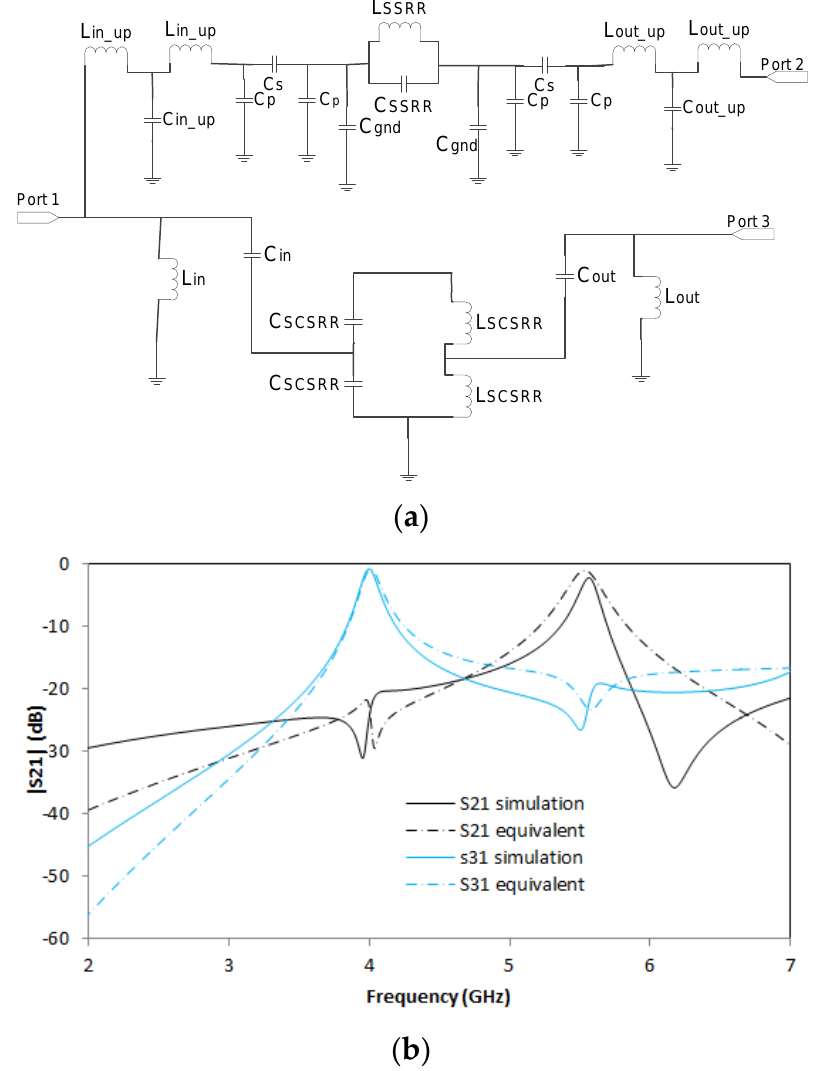
Figure 18. ( a ) Equivalent circuit of diplexer with SSRR on top and SCSRR on ground plane. ( b ) Simulated S21 (dashed black line) and simulated S31 (dashed blue line). Equivalent circuit S21 (dashed-dotted black line) and equivalent circuit S31 (dashed-dotted blue line).